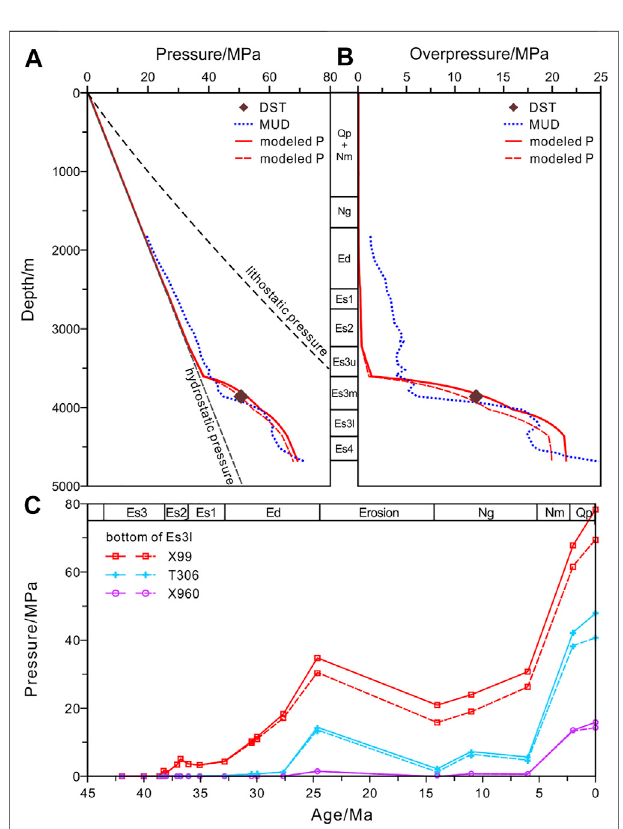
FIGURE 12 | Modeling results of different overpressure mechanisms in the Linnan Sag. (A) The modeled pore pressure in well X99. (B) The modeled overpressure in well X99. (C) Pore pressure evolution for three wells in the Linnan Sag. The solid lines are the excess pressure with hydrocarbon generation, and the dashed lines are without hydrocarbon generation. The well locations are shown in Figure 1 .